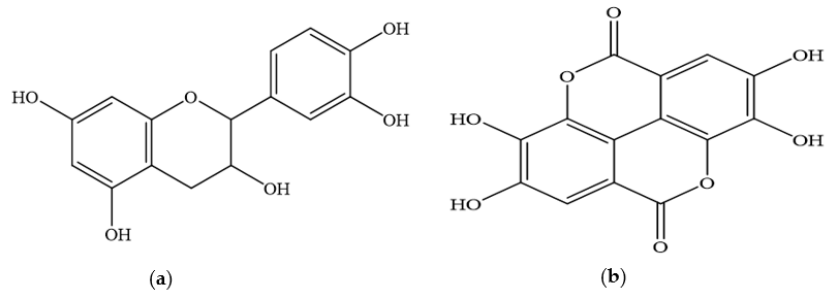
Figure 6. Structure of Catechin ( a ) and Ellagic acid ( b ). In addition to some phenolic constituents, volatile components present in different clover species have also been determined. A study, carried out by Massei et al. [57], iden- tified volatile components (Table 5 and Figure 7) in red clover, strawberry clover and white clover. ( E )-3-Hexenyl acetate and ( E )-3-hexenol were present in all three species, but in substantially larger amounts in white clover. Two major volatiles of white clover, 2- propanone and 2-butanone, were found only in this species. These two key volatiles were found to be released in significant quantities from the oil extract alongside smaller amounts of ( E )-3-hexenal, 1-octen-3-ol and ( E )-3-hexenyl acetate as well as ( E )-3-hexenol, which was produced by damaging the growing plant [58]. It has also been found that white clover contains cyanogenic glycosides, which liberate toxic levels of hydrogen cya- nide (HCN) and so provide an immediate chemical defense response to herbivores and pathogens causing damage [30]. Table 5. Compounds reported in clover plants and clover honeys.